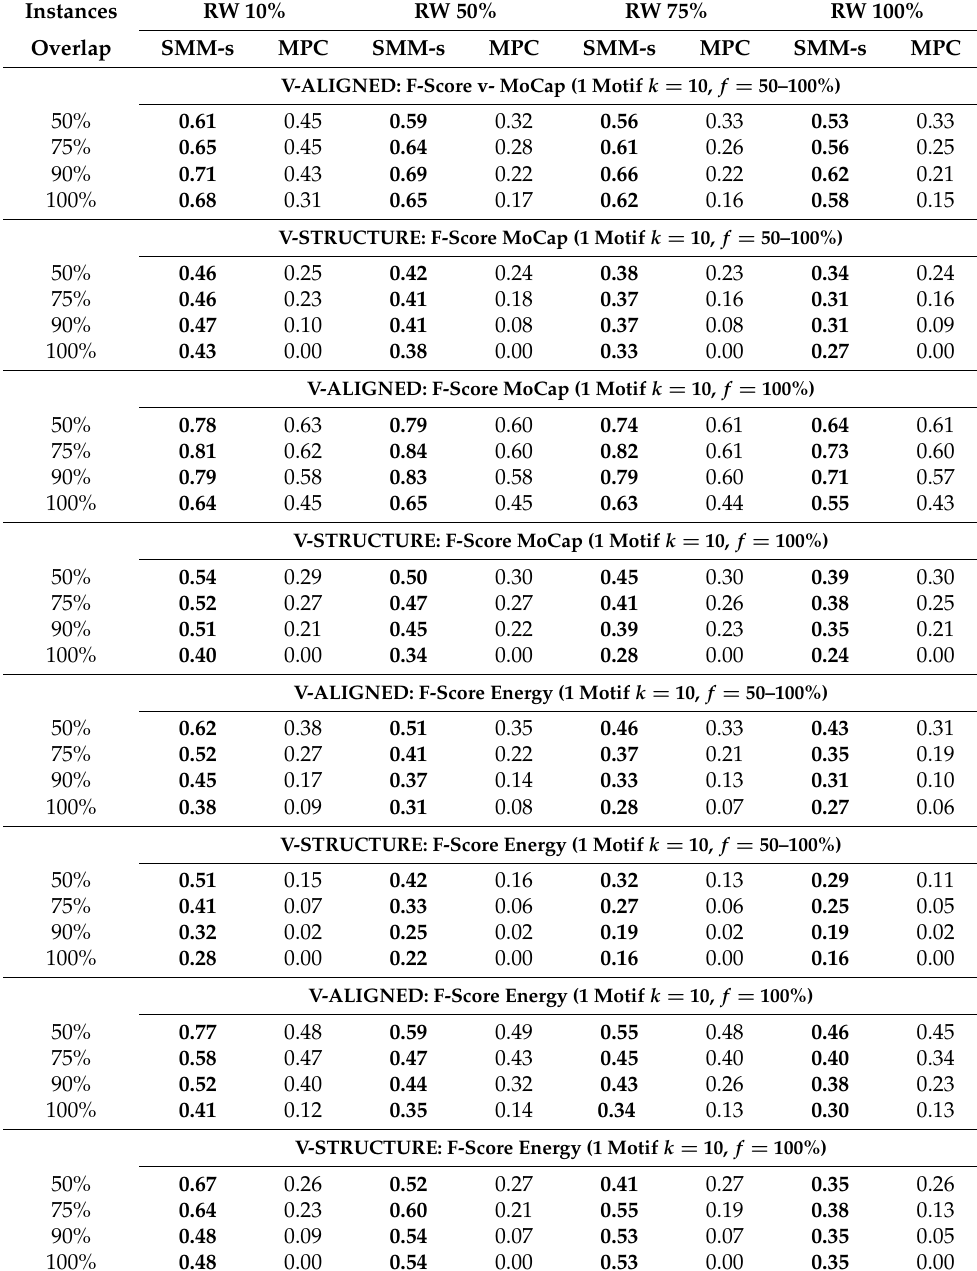
Table 6. F-scores for time series with recurring patterns that are variate-aligned ( v-aligned ) vs. non- variate-aligned ( v-structure ) from MoCap and